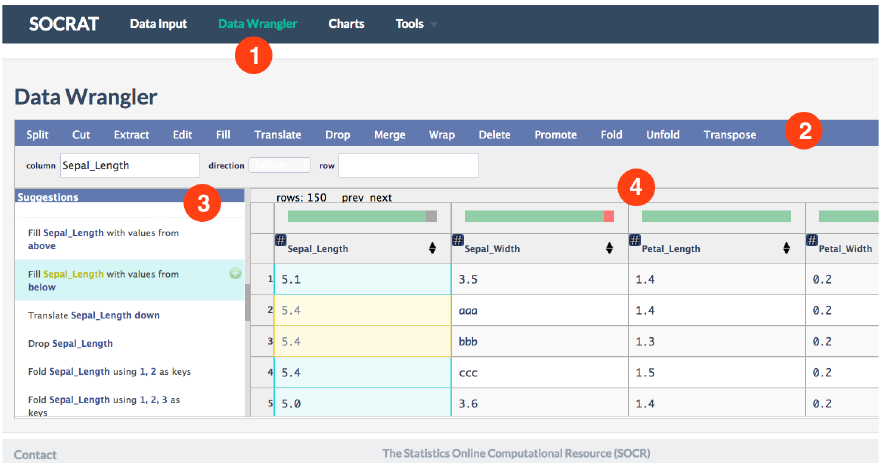
Figure 4. Data Wrangler module overview: ( 1 ) it features original Wrangler interface integrated into SOCRAT; ( 2 ) all original Wrangler operations are included; ( 3 ) Data Wrangler hides standard SOCRAT sidebar to free up space for Wrangler transformation suggestions panel; ( 4 ) Wrangler data diagnostic shows indicators of missing and erroneous values and inferred data types for dataset loaded from Database